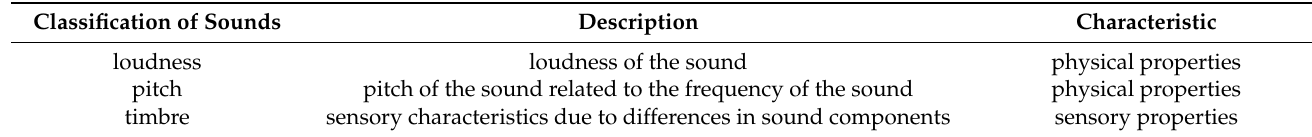
Table 5. Classification and characteristics of